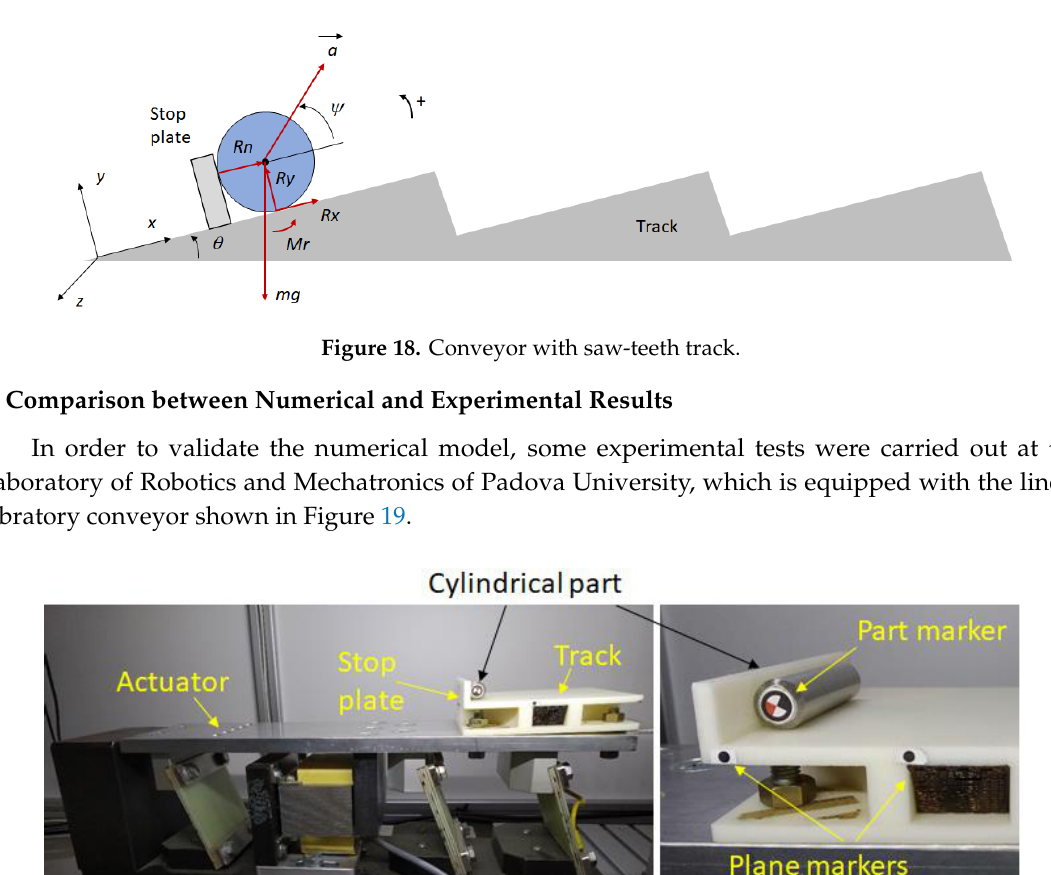
Figure 20. Comparison between numerical ( a ) and experimental ( b ) results. 𝜃 = 3° , 𝜓 = 10° , 𝑓 = 55 Hz, 𝑎 𝑔 ⁄ = 2.254, 𝑘 = 1000000 N/m, 𝑓 𝑣 = 0.005 , 𝜇 𝑐 = 0.35 and 𝜇 𝑠 = 0.7.